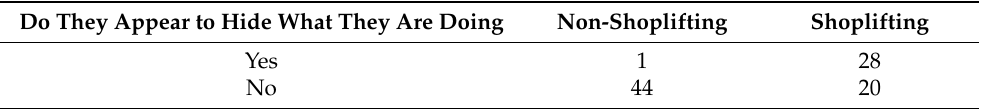
Table 9. Frequency of the attribute “Do they exhibit avoidance